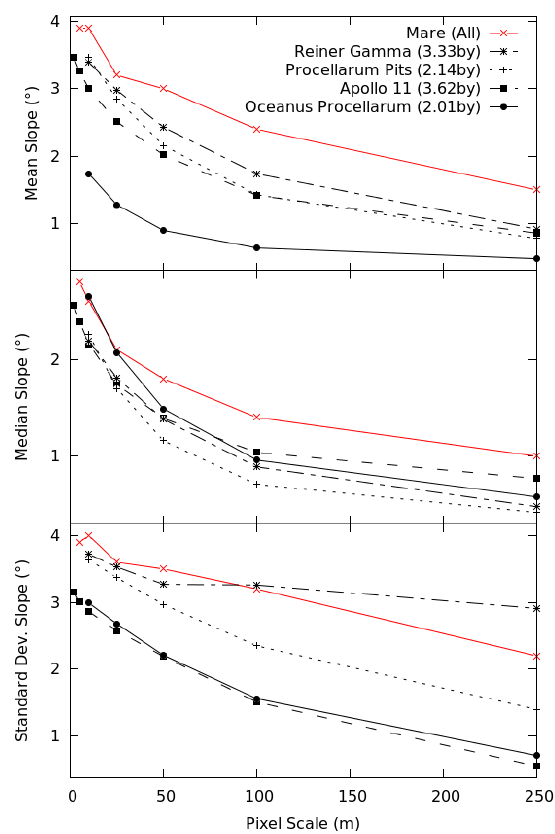
Figure 3. Mean, median, and standard deviation of slopes for DTMs of typical mare units compared to all mare DTMs. Curve marked “All” represents NAC mare DTM population analysed in Henriksen et al.